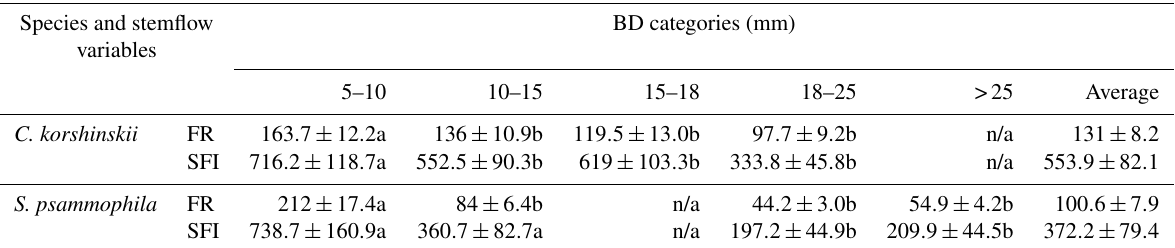
Table 4. Comparisons of the stemflow intensity and funneling ratio at different basal diameter categories. Species and